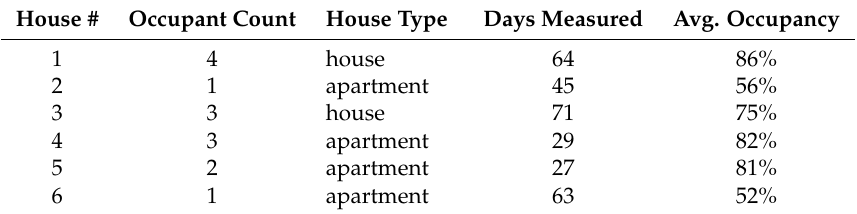
Table 1. Summary of residences measured during